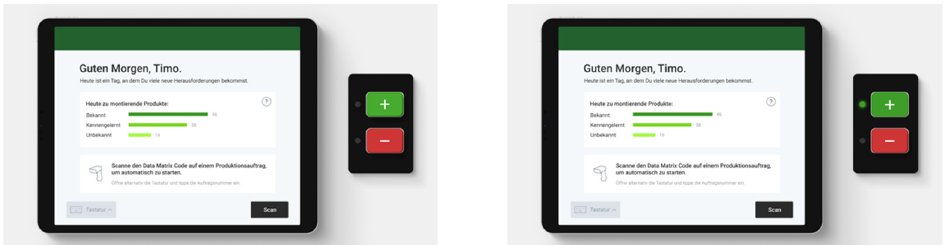
Figure 1. Virtual setup of the experimental setting. Virtual tablet in the center shows Table 2. To the right of virtual tablet, there is a virtual remote control for setting positive (green plus button) and negative (red minus button) valence markers. Right keyboard shows how a virtual indicator light (here: green) illuminates in response to pressing the (green plus) button.